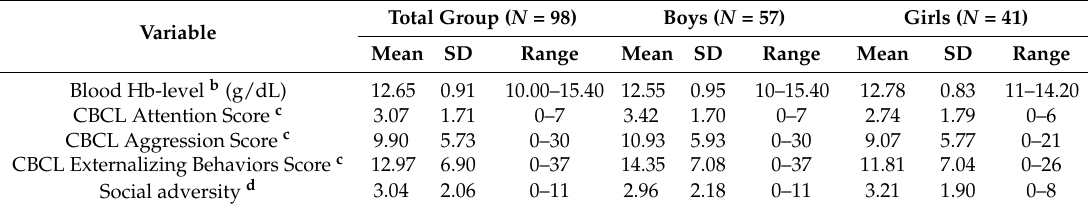
Table 1. Descriptive statistics of all independent and dependent variables a included in